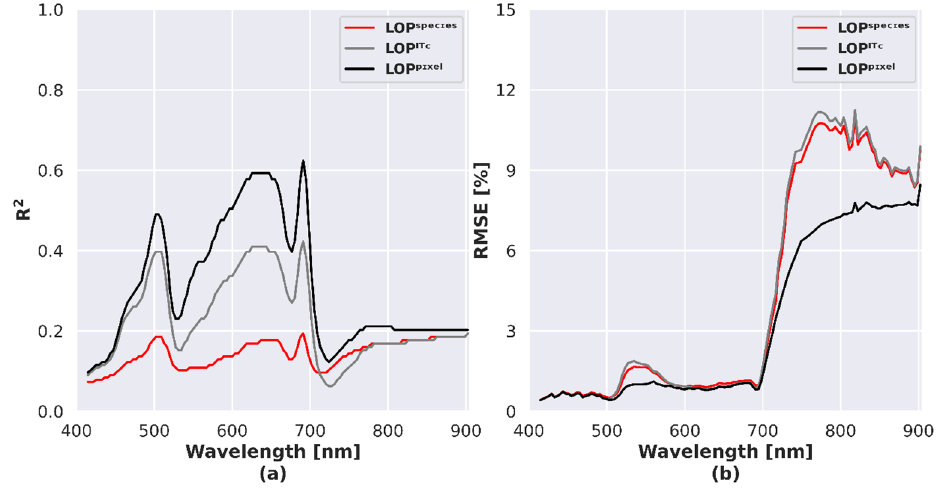
Figure 10. Spectral variation of ( a ) R 2 and ( b ) RMSE derived from NPVf Cbrown for the different scenarios accounting for LOP variability.